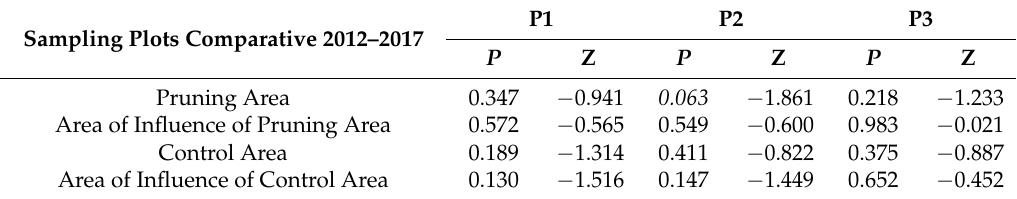
Table 6. Statistical comparison of the Population Intensity recorded in 2012 with respect to those of 2017 in the whole of the areas sampled at each sampling plot (P1, P2, and P3). Z = Value of the statistic for the Mann-Whitney U test; P = Probability ( α ≤